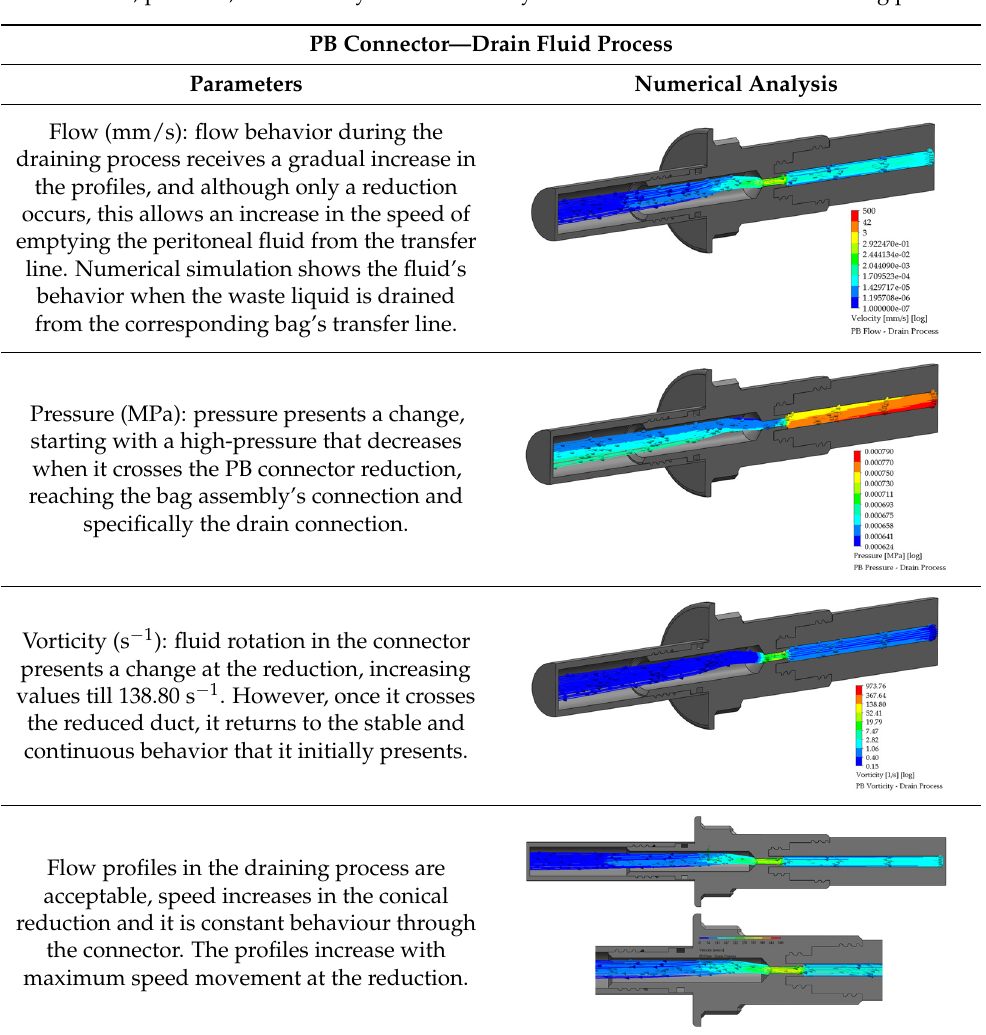
Table 7. Flow, pressure, and vorticity behavior of the fluid in the BP and PB connectors in the infusion